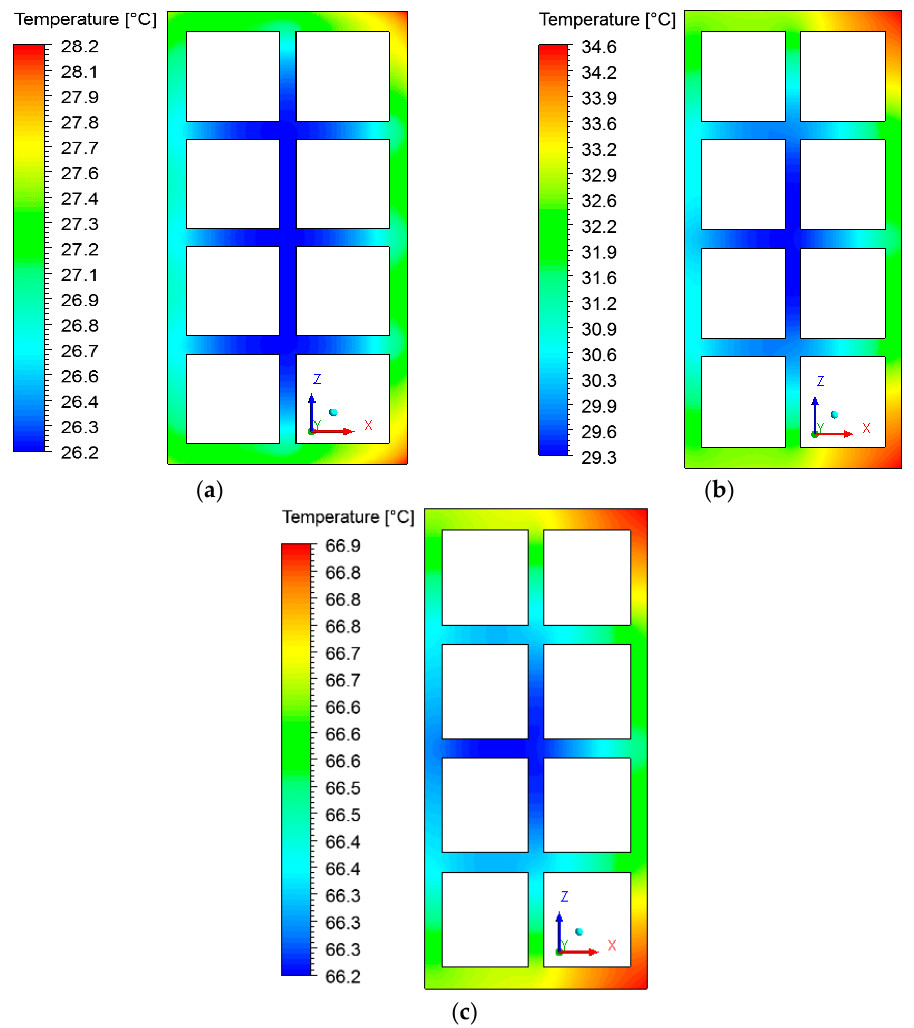
Figure 7. Temperature fields inside the ceramic brick at different moments of drying: ( a ) 10 min, ( b ) 60 min, and ( c ) 950 min.